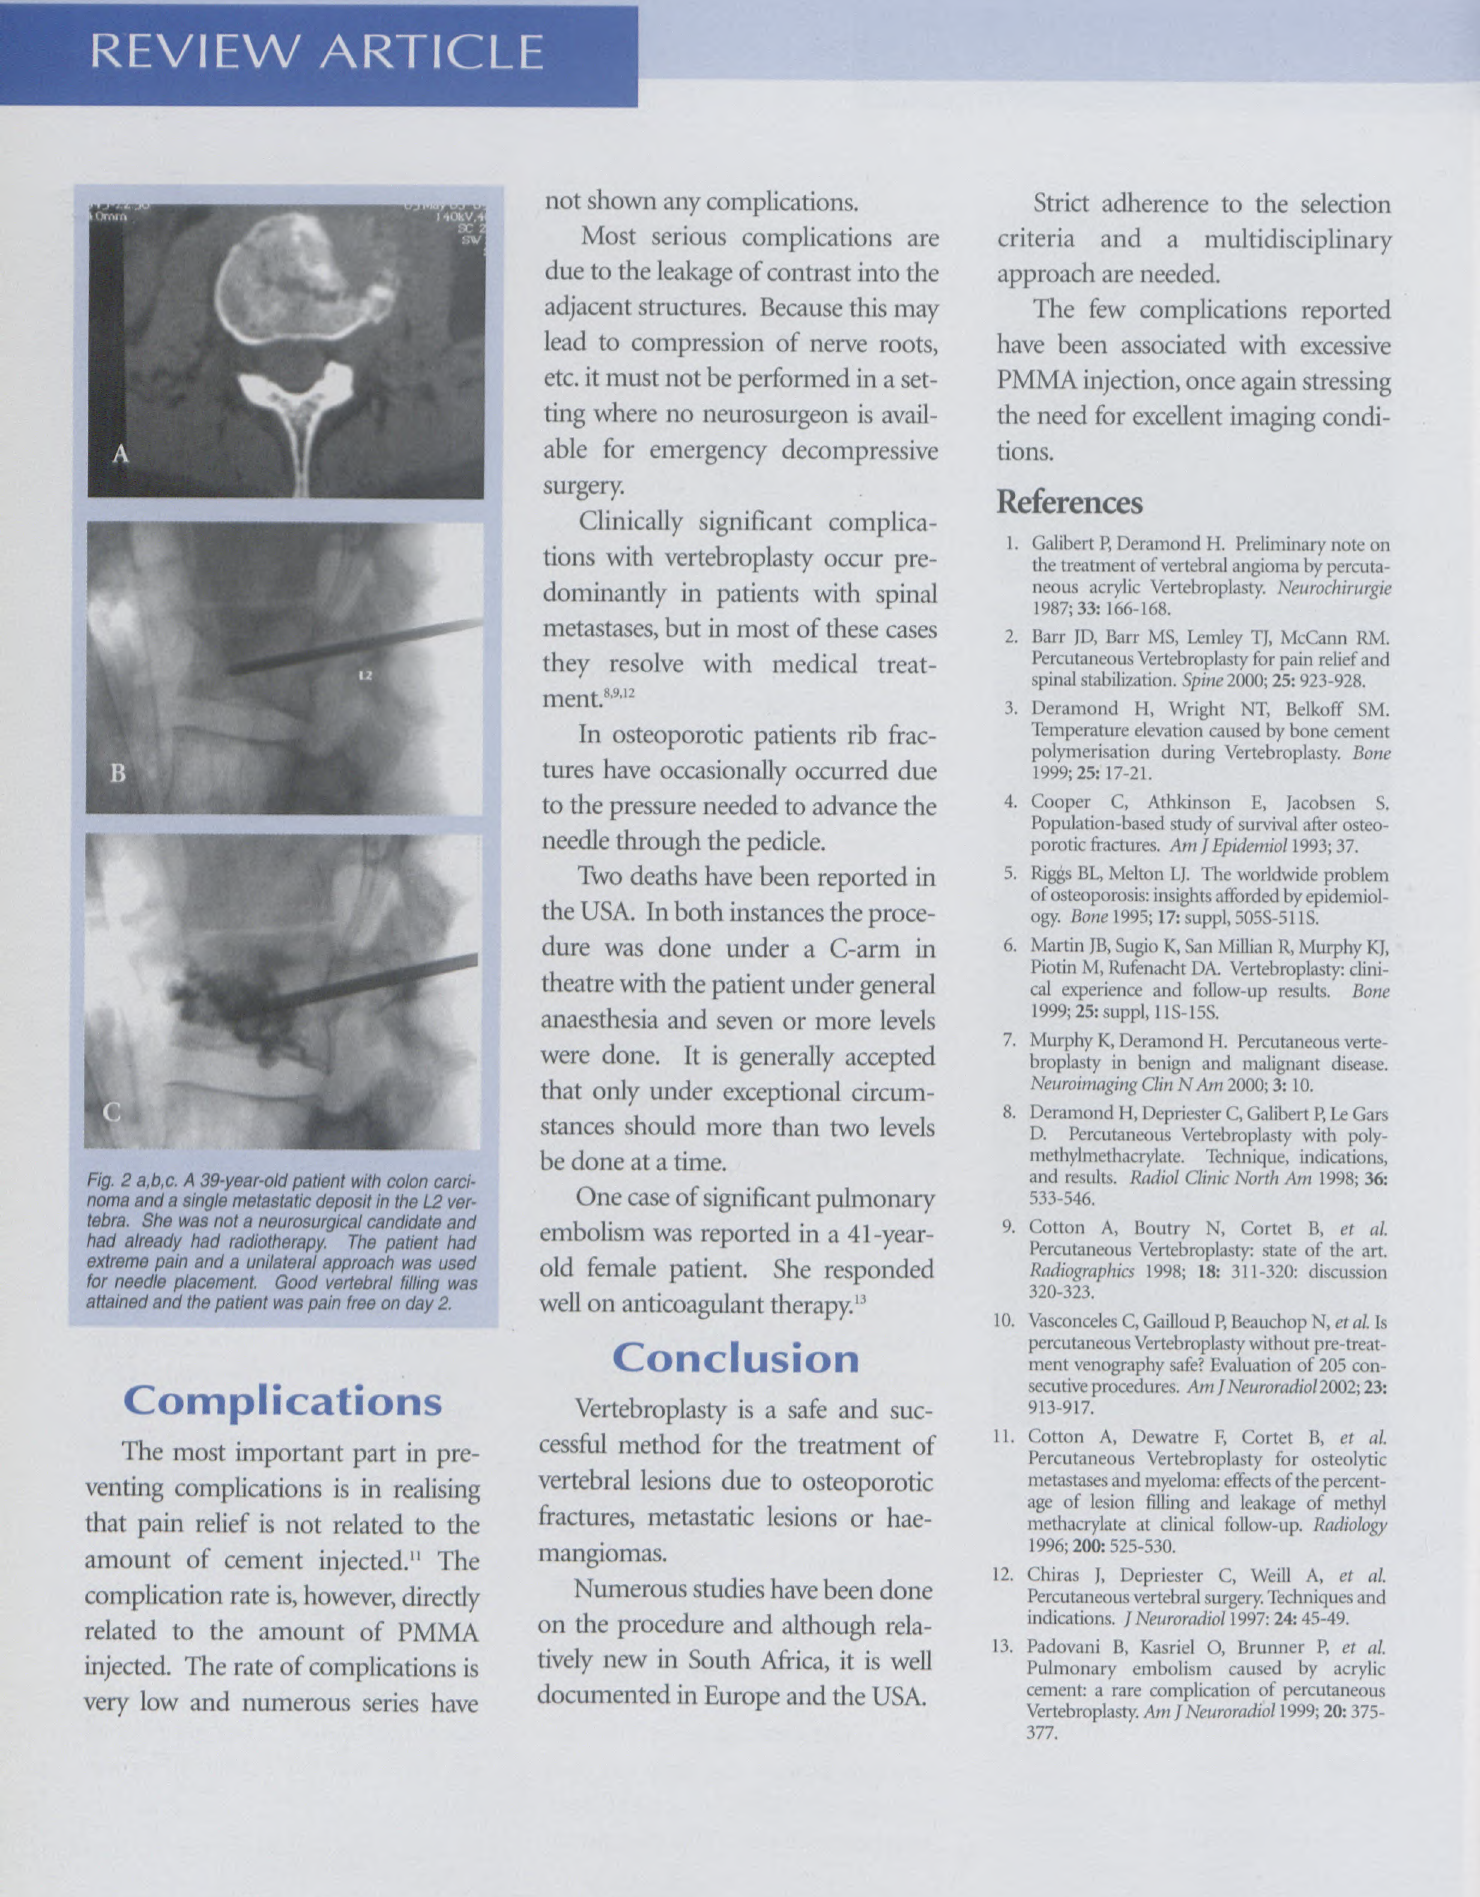
Fig. 2 a,b,c. A 39-year-old patient with colon carci- noma and a single metastatic deposit in the L2 ver- tebra. She was not a neurosurgical candidate and had already had radiotherapy. The patient had extreme pain and a unilateral approach was used for needle